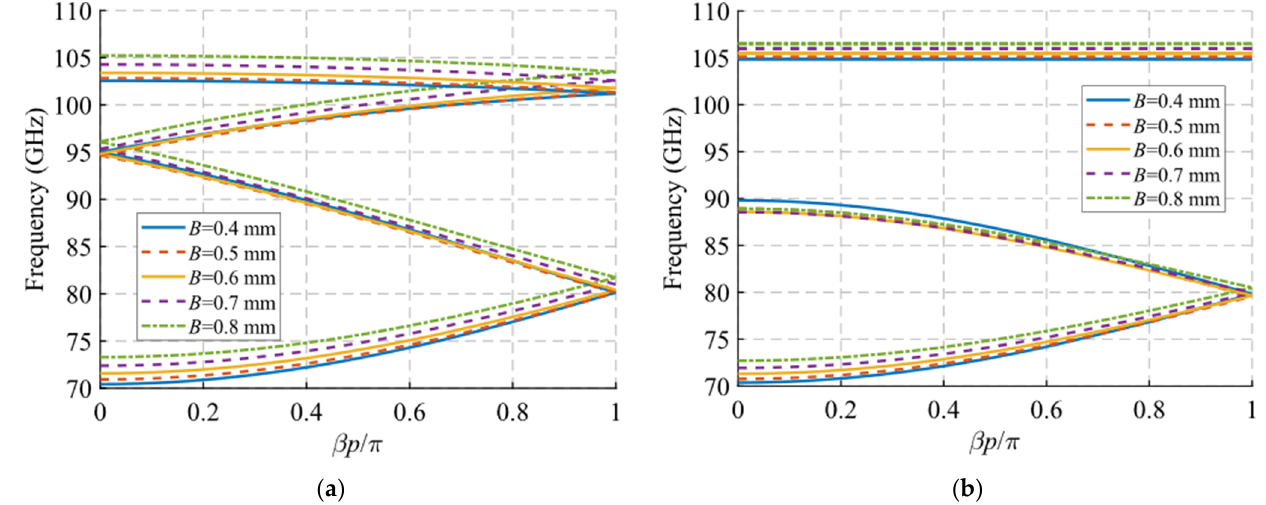
Figure 9. Dispersion diagram of the double-periodic unit cell for various values of B . ( a ) Glide-symmetric configuration ( d = 0.725 mm) and ( b ) maximum rupture of symmetry configuration ( d = 0 mm).